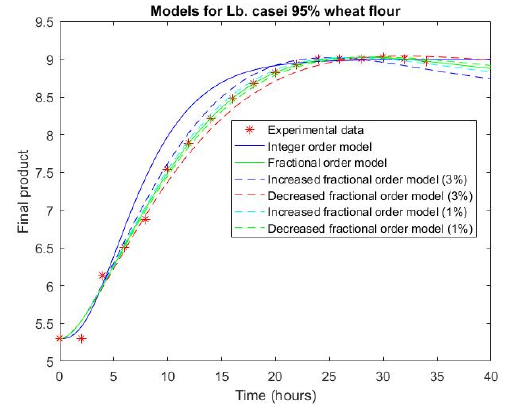
Figure 5. Comparison between simulated and experimental data for experiment 2 using L. casei .